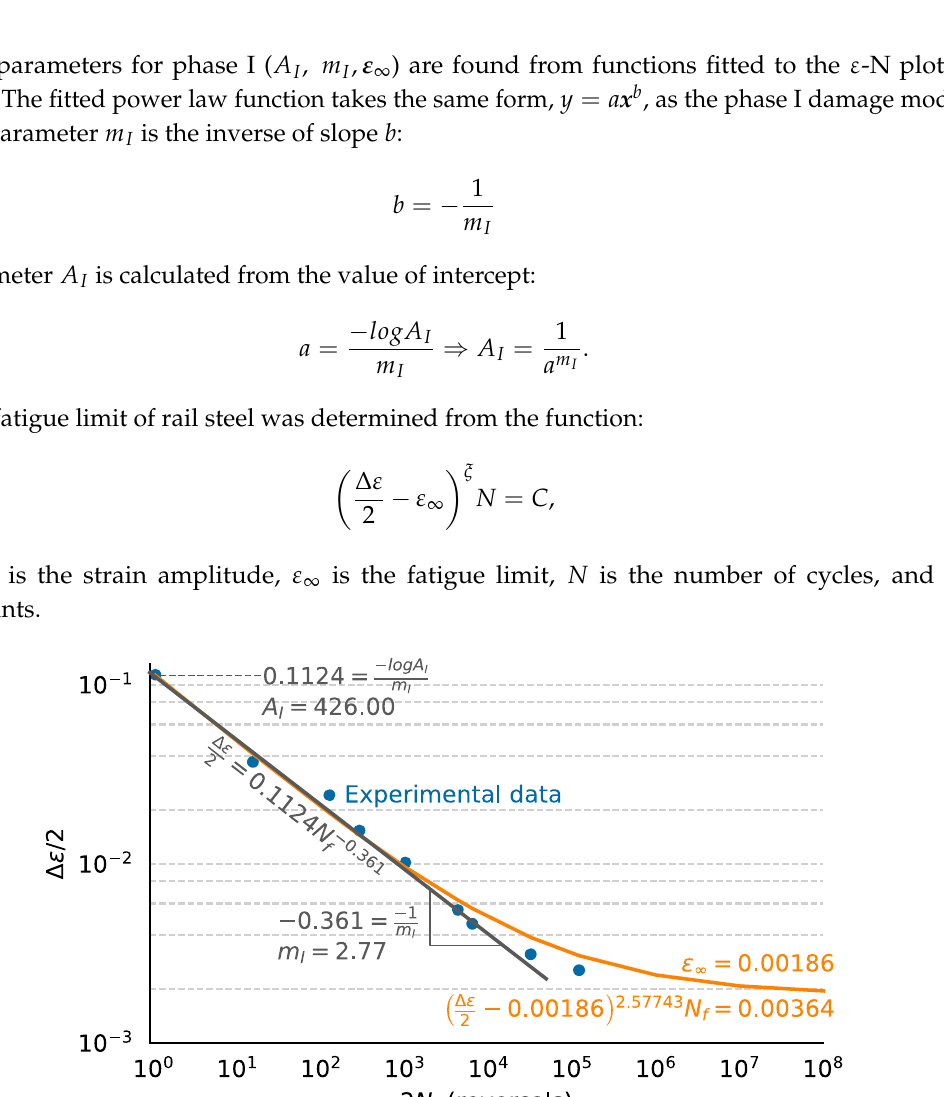
Table 3. Fatigue damage model parameters.